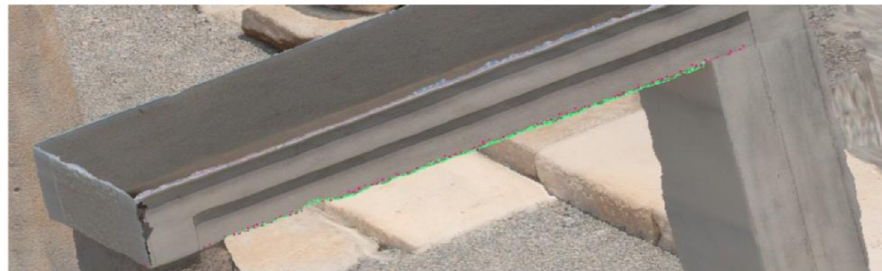
Figure 8. Display of the selected 3D points belonging to the requested 3D edge using the algorithm, (colored in purple) compared to the real word 3D edge obtained by the 3D scanner (colored in green).